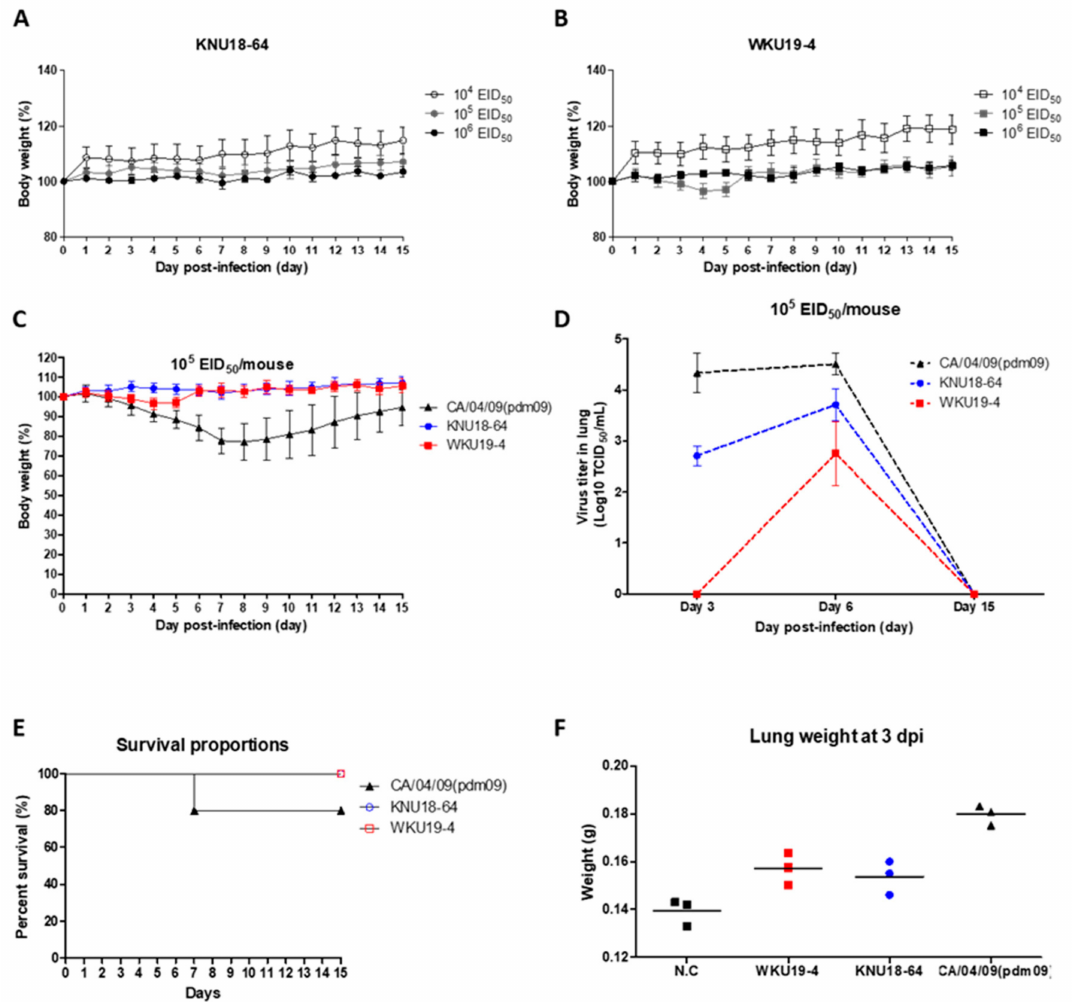
Figure 5. Pathogenicity of the two H1N1 isolates in vivo. For each isolate, BALB/c mice were intranasally infected with different EID 50 concentrations of the virus (10 4 , 10 5 , and 10 6 EID 50 /mouse). Changes to the weights of the mice are shown for KNU18-64 ( A ) and WKU18-4 ( B ), and the survival rates were noted. The BALB/c mice were intranasally challenged with 10 5 EID 50 of each virus, and a H1N1 (2009) strain isolated from humans (CA/04/09(pdm09)) was used as a control virus. Weights of the mice ( C ); virus titers in the lung ( D ); survival rates ( E ); mean of lung weights ( F ) ( n = 3); Body weights are presented as percentages of the original weight ( n =